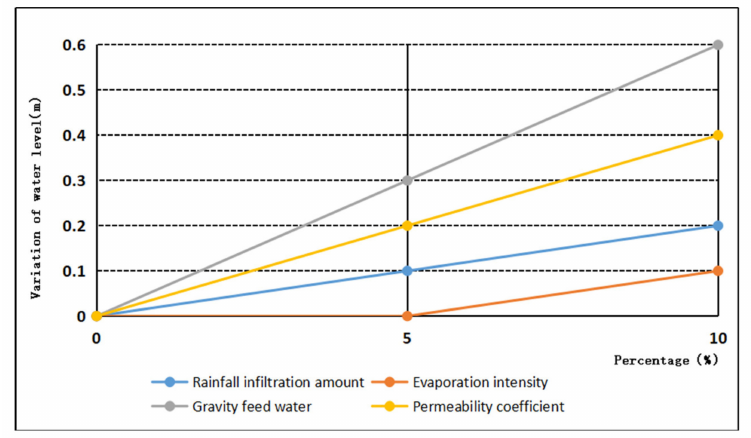
Figure 7. Results of the parameter sensitivity